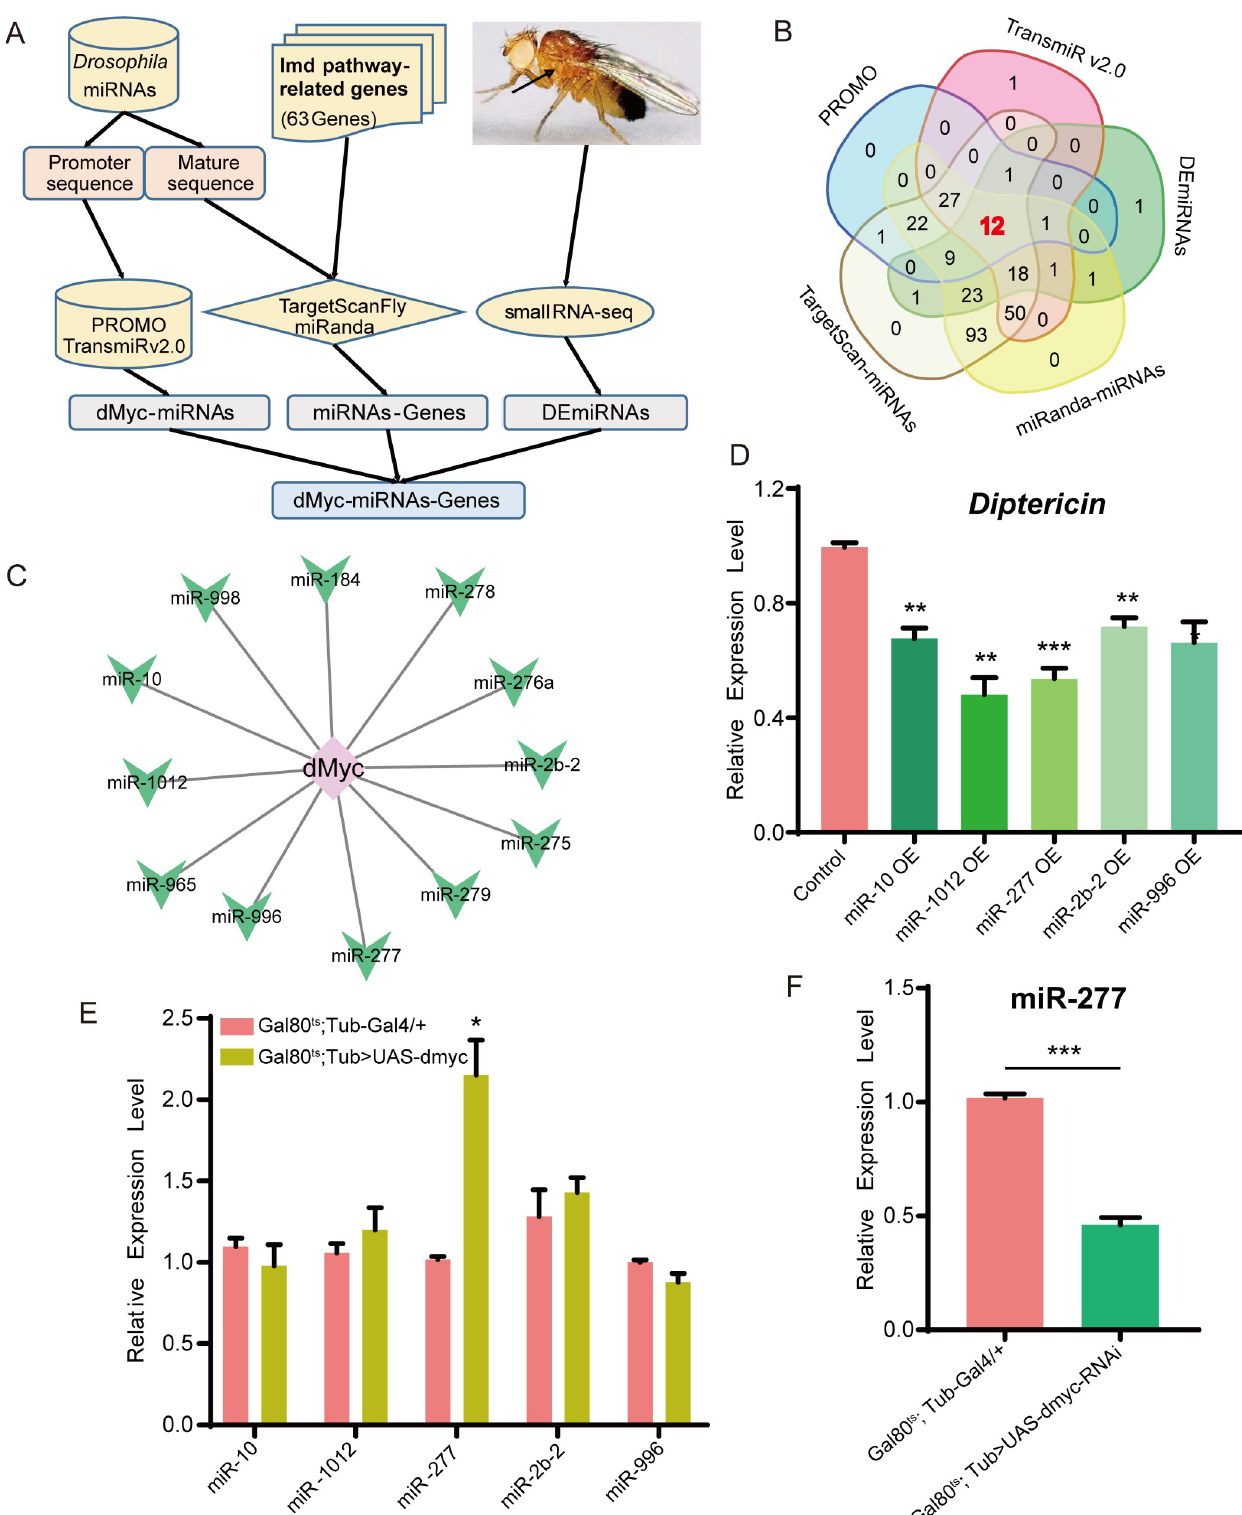
Fig 2. The screening of dMyc regulating Drosophila immune related miRNAs. (A) The flowchart showed the process of obtaining a batch of potential immune-related dMyc-miRNAs-Genes axes using bioinformatics tools. (B) The Venn diagram exhibited that the intersection of miRNAs that dMyc